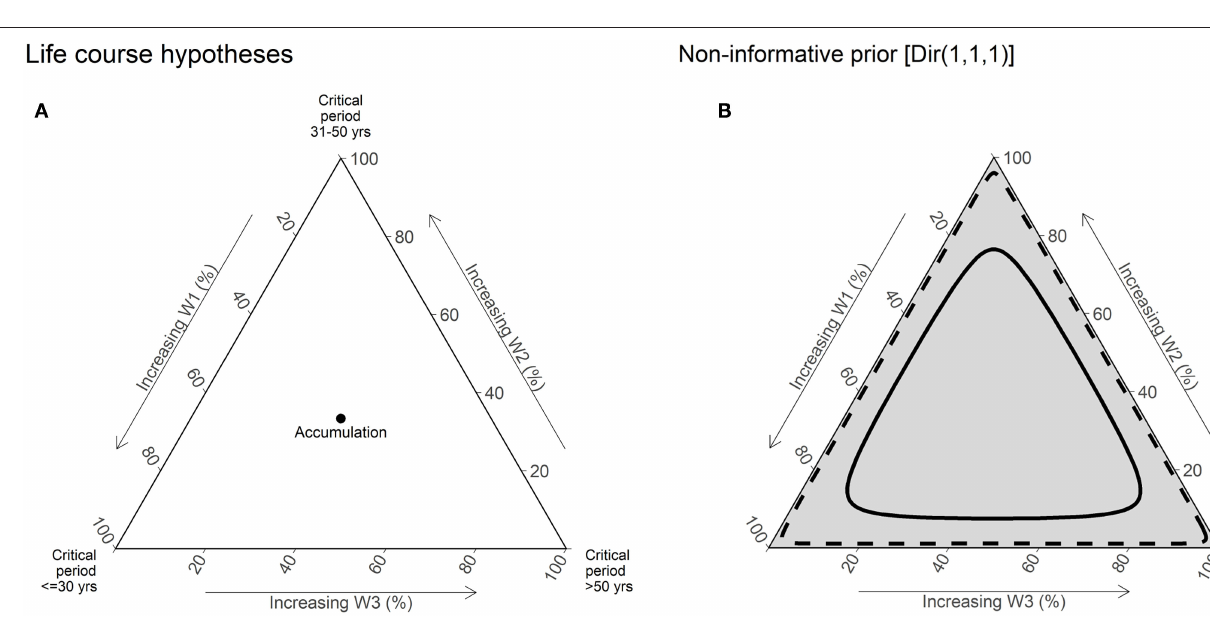
FIGURE 2 | Illustration of life course hypotheses and non-informative prior distribution [Dir (1,1,1)]. (A) This ternary plot is used to visualize the joint distribution of weights for three periods. Vertices of the plot represent the extreme values of weights ([1,0,1] or [0,1,0] or [0,0,1]), and thus critical period hypotheses. The central point of the plot where the weights have equal value [0.333, 0.333, and 0.333] represents the accumulation hypotheses. The edges of the plot are labeled in % scale, which increases toward the corresponding vertices. (B) The gray shading of the plot represents the relative density of the prior joint distribution at specific point s in the plot. In other words, the prior belief on the value of weights. The solid line represents the 50% credible interval (CrI), and the dashed line represents the 95% CrI of the joint distribution. Under a non-informative prior distribution, all points in the plot are assumed to have equal probability and hence are shaded